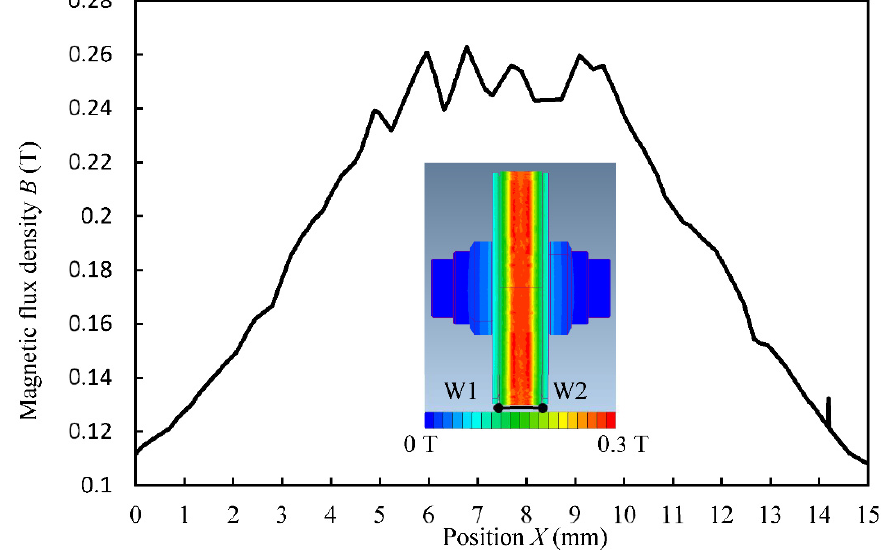
Figure 6. Magnetic field distribution in the width direction of the conveyor belt.